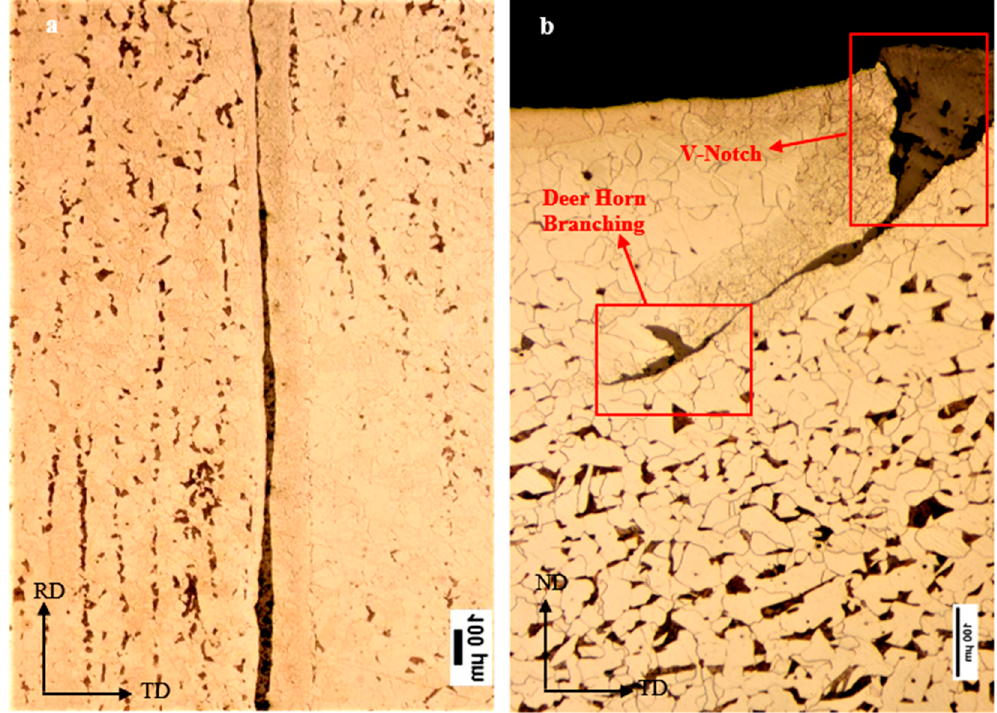
Figure 6. Optical microscope images of cracks ( a ) from the top and ( b ) perpendicular to the crack.